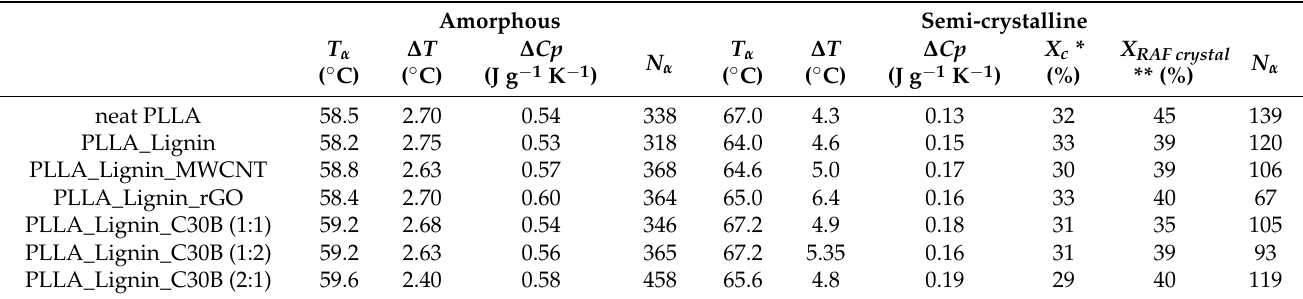
Table 2. Rigid amorphous fraction and crystalline-phase contents, as well as the characteristic amorphous-phase parameters extracted from the C’ and C” signals ( ∆ Cp , T α , and ∆ T ) that were used for the CRR-size calculation. Amorphous Semi-crystalline